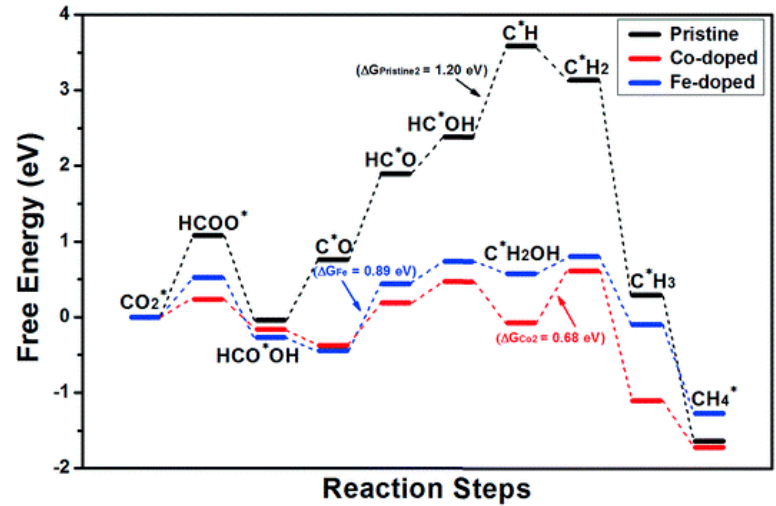
Figure 2. The free energy diagram showing the pathway of CO 2 reduction on pristine and Co/Fe doped CsPbBr 3 . Reproduced from [63], Royal Society of Chemistry, 2019.